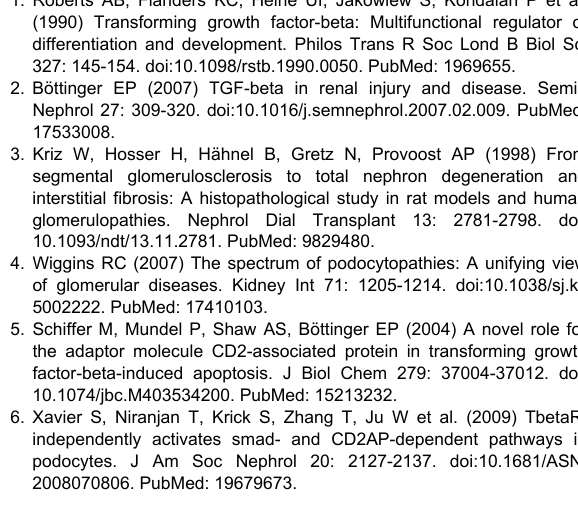
Figure S2. miR-30 precursors were downregulated in